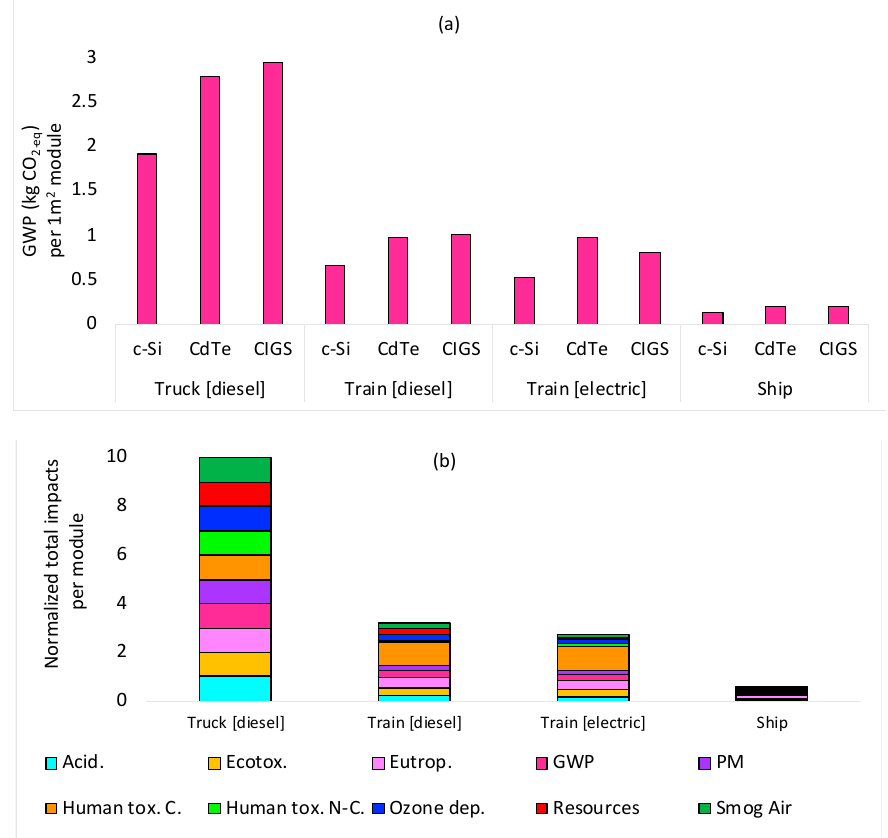
Figure 2. Environmental impacts of transportation of PV module ( a ) global warming potential (GWP) emissions of transportation ( b ) total normalized environmental impacts of PV transportation. Note that the calculations for transportation vehicles were performed assuming the average weight of PV module as 20 kg.